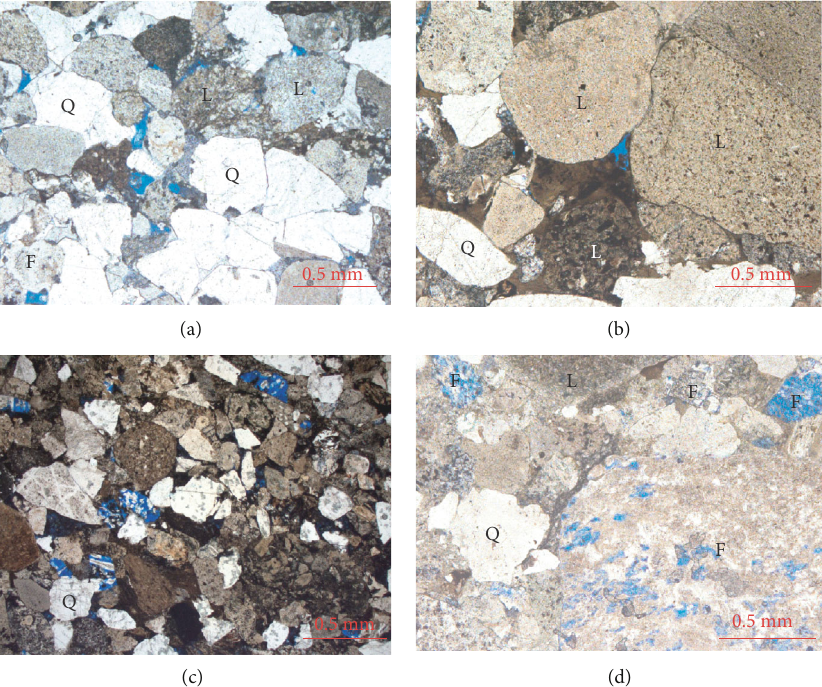
Figure 2: Pore types for di ff erent diagenetic phases: L: lithic clast; Q: quartz; F: feldspar. (a) Well X89, 2477.27m: residual intergranular pore and dissolved pore development, primarily line contact between particles and surface crack development for quartz particles. (b) Well M23, 3641.29m: strong compacted diagenesis, line contact between particles with a few residual intergranular pore. (c) Well MZ2, 4201.94 m: feldspar dissolved into intragranular pores. (d) Well M18, 3852.55m: line contact between particles and feldspar